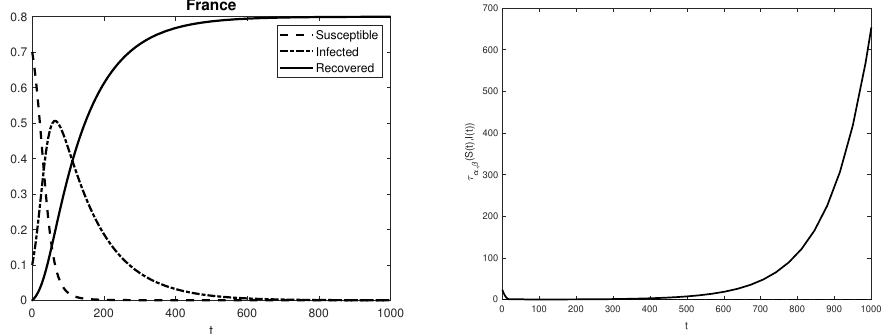
Figure 3. Solution to the SIR model (1), with initial value given by the vector (4), for France ( left ) aand corresponding pattern of τ α , β ( S ( t ) , I ( t )) ( right